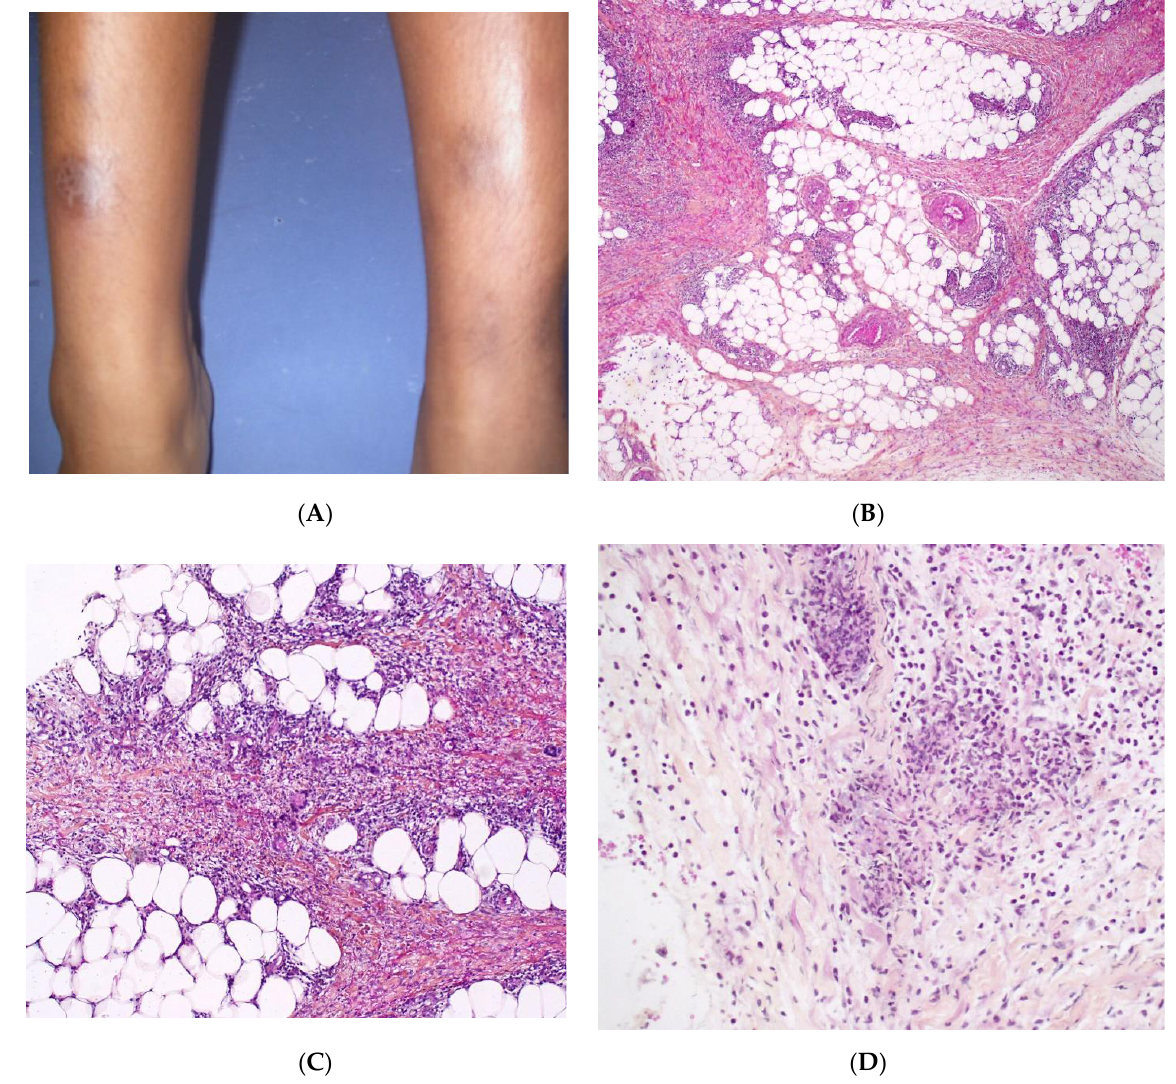
Figure 7. Erythema nodosum. ( A ) Nodules of the legs in an 8-year-old child. Photo Dermatology Department Hopital Necker Enfants Malades. Paris France . ( B ) Fibrosing septal pattern with involvement of the periphery of the fat lobules. The process extends into the fat lobules (original magnification × 40). ( C ) Thickened septa of subcutaneous fat with granulo- matous inflammation (original magnification × 100). ( D ) Miescher granuloma consisting of small nodular aggregation of histiocytes around a central stellate-shaped cleft located near the junction of the adipocytes and the septum (original magnification ×